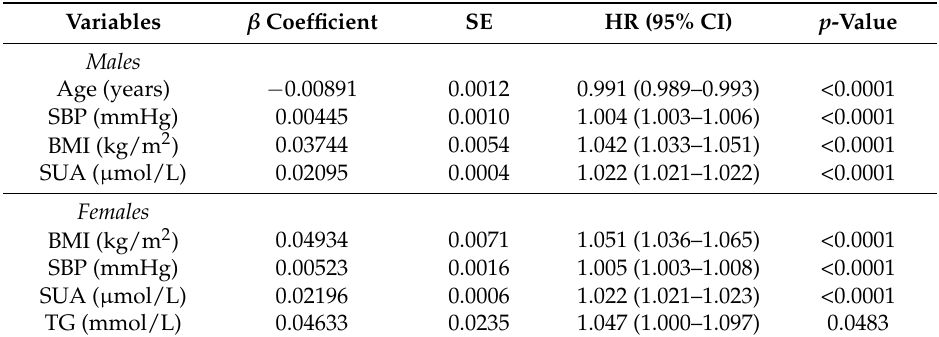
Table 3. Multivariable-adjusted Cox proportional hazards regression coefficients for three-year risk of hyperuricemia.